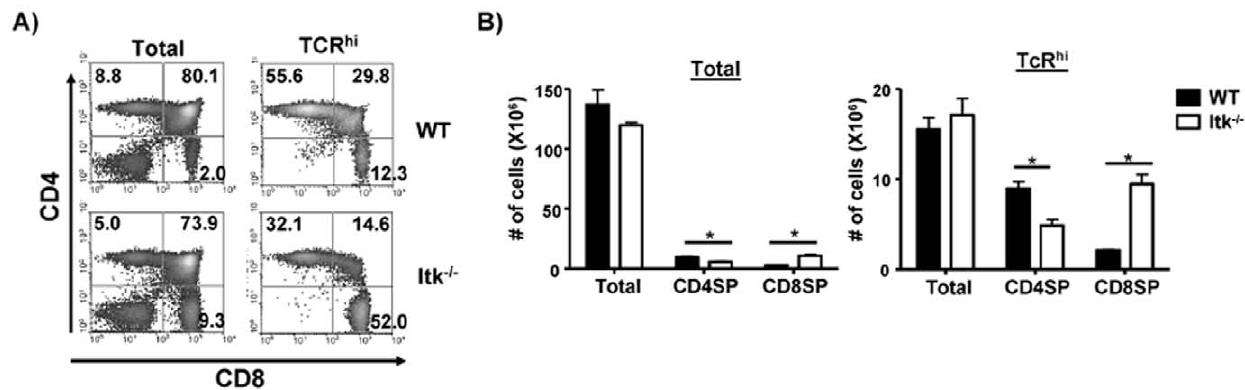
Figure 1. The absence of Itk affects the development of CD4 and CD8 T cells. ( A ) Thymocytes from WT or Itk 2 / 2 mice were analyzed for expression of CD4 and CD8 (left), or gated first on the TCR hi population and analyzed for CD4 and CD8 (right). ( B ) The number of thymocytes (total, left) or TCR hi thymocytes (right) in WT and Itk 2 / 2 mice. *p , 0.05, n=3–5 mice.